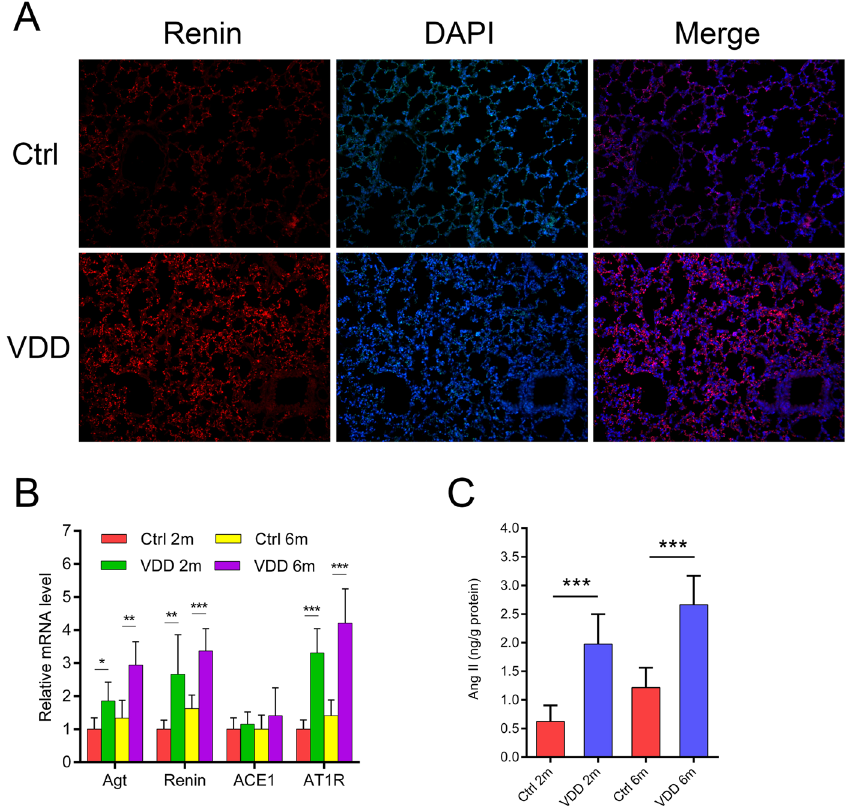
Figure 3. Vitamin D deficiency activates pulmonary RAS. ( A ) Immunofluorescence staining of the lung tissue with renin after two months of vitamin D deficiency. Original magnification: 200 × . ( B ) Relative mRNA expressions of RAS components by real-time PCR. * P < 0.05, ** P < 0.01, *** P < 0.001 Ctrl versus VDD group of the same age (n = 5–6 in each group). ( C ) Serum angiotensin II concentration in the mice after 2 months and six months of vitamin D deficiency. *** P < 0.001 Ctrl versus VDD group of the same age (n = 5–6 in each group). Agt: angiotensinogen; Ang: angiotensin; ACE1: angiotensin converting enzyme 1; AT1R: angiotensin type 1 receptor; Ctrl: control; VDD: chronic vitamin D deficiency; 2 m: 2 months; 6 m: 6 months. Statistics: Independent-sample two-tailed t